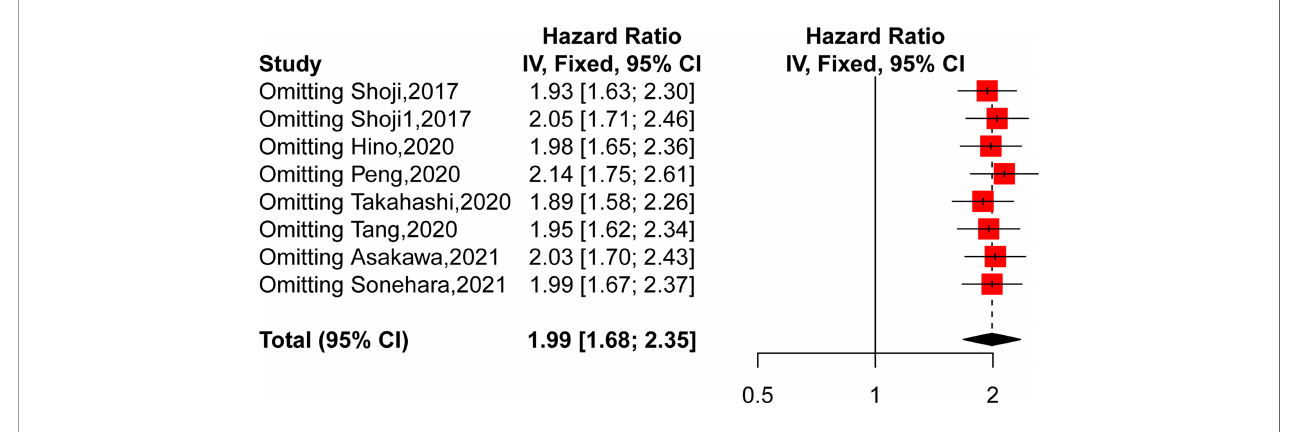
FIGURE 3 | Sensitivity analysis by excluding each study from the meta-analysis.